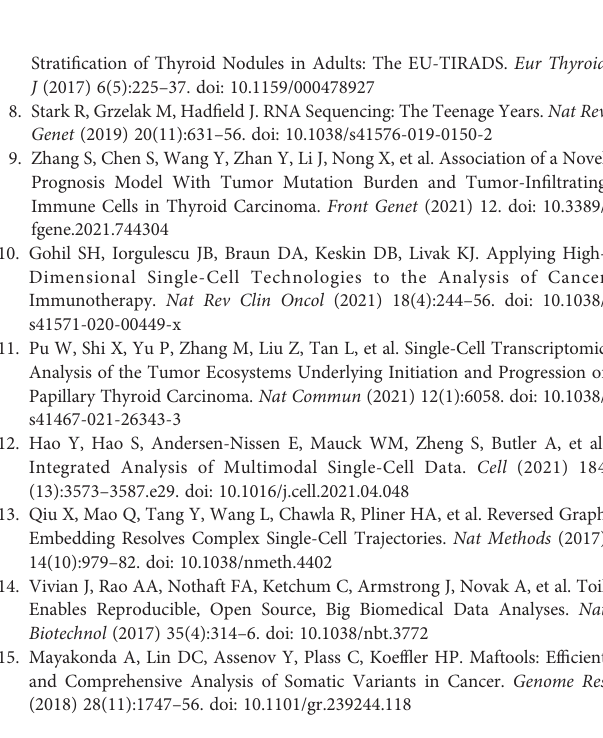
Supplementary Figure 1 | Annotation of cell type. (A) Marker genes of different cell clusters in 4 tumor samples. (B) UMAP of cell clustering in 4 tumor samples. (C) Marker genes of different cell clusters in 4 normal samples. (D) UMAP of cell clustering in 4 NORMAL samples. Supplementary Figure 2 | Annotation of cell type. (A) KM plot of genome-level altered group and unchanged group. (B-D) Relationship between DNA methylation sites and gene expression of three prognosis related